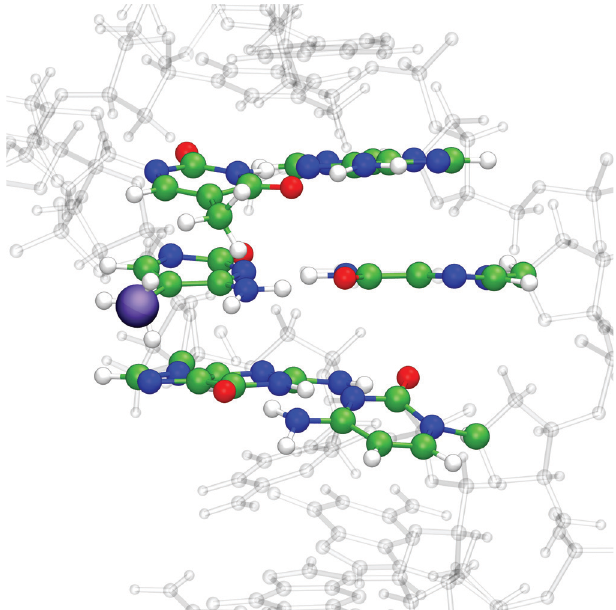
Figure 6. QM/MM optimised structure of 5´-ATTCGCG-3´ with 5-mC in central position, and the bases defined as QM atoms shown in CPK. A purple sphere highlights the methylation position, and water molecules and counterions have been omitted for